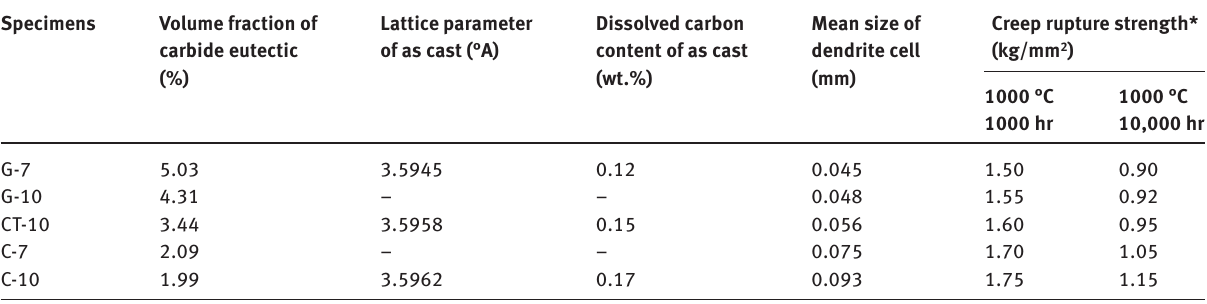
Table 4: Structural variations and creep rupture strength of HK40 [15]. Specimens